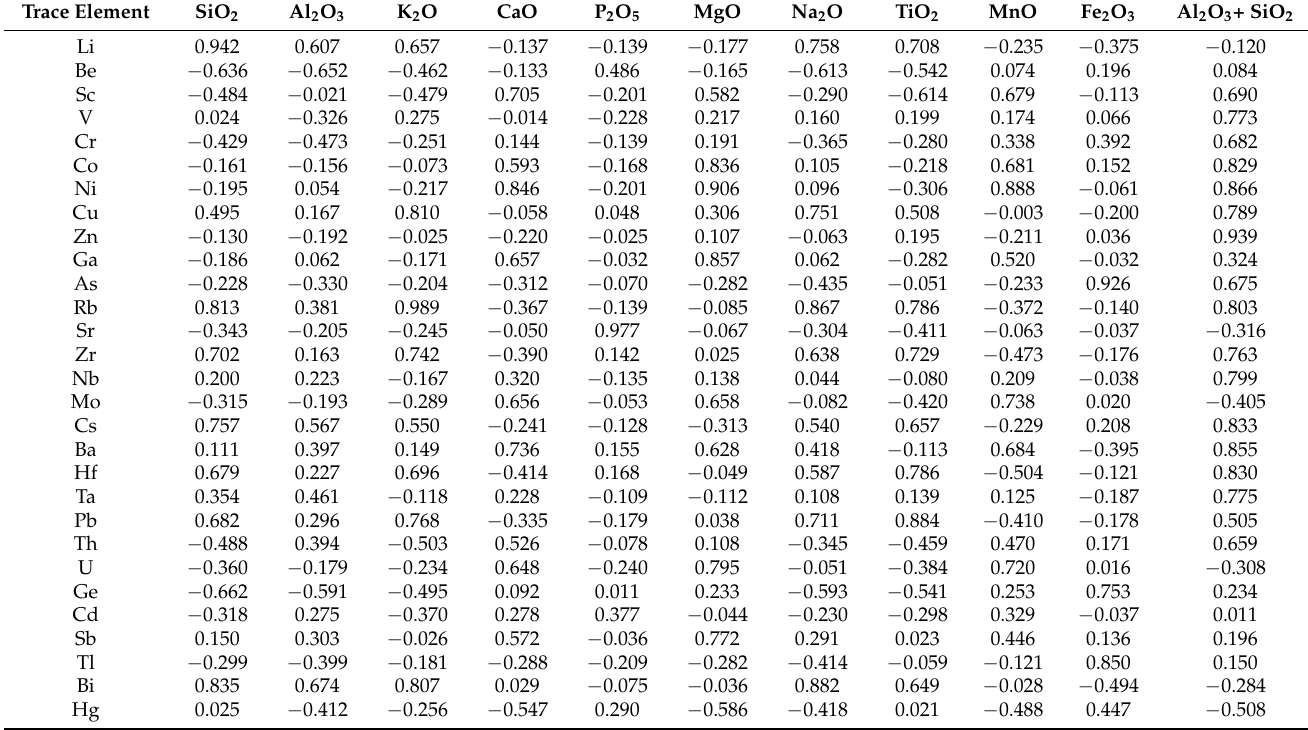
Table 5. The correlations between trace elements and major